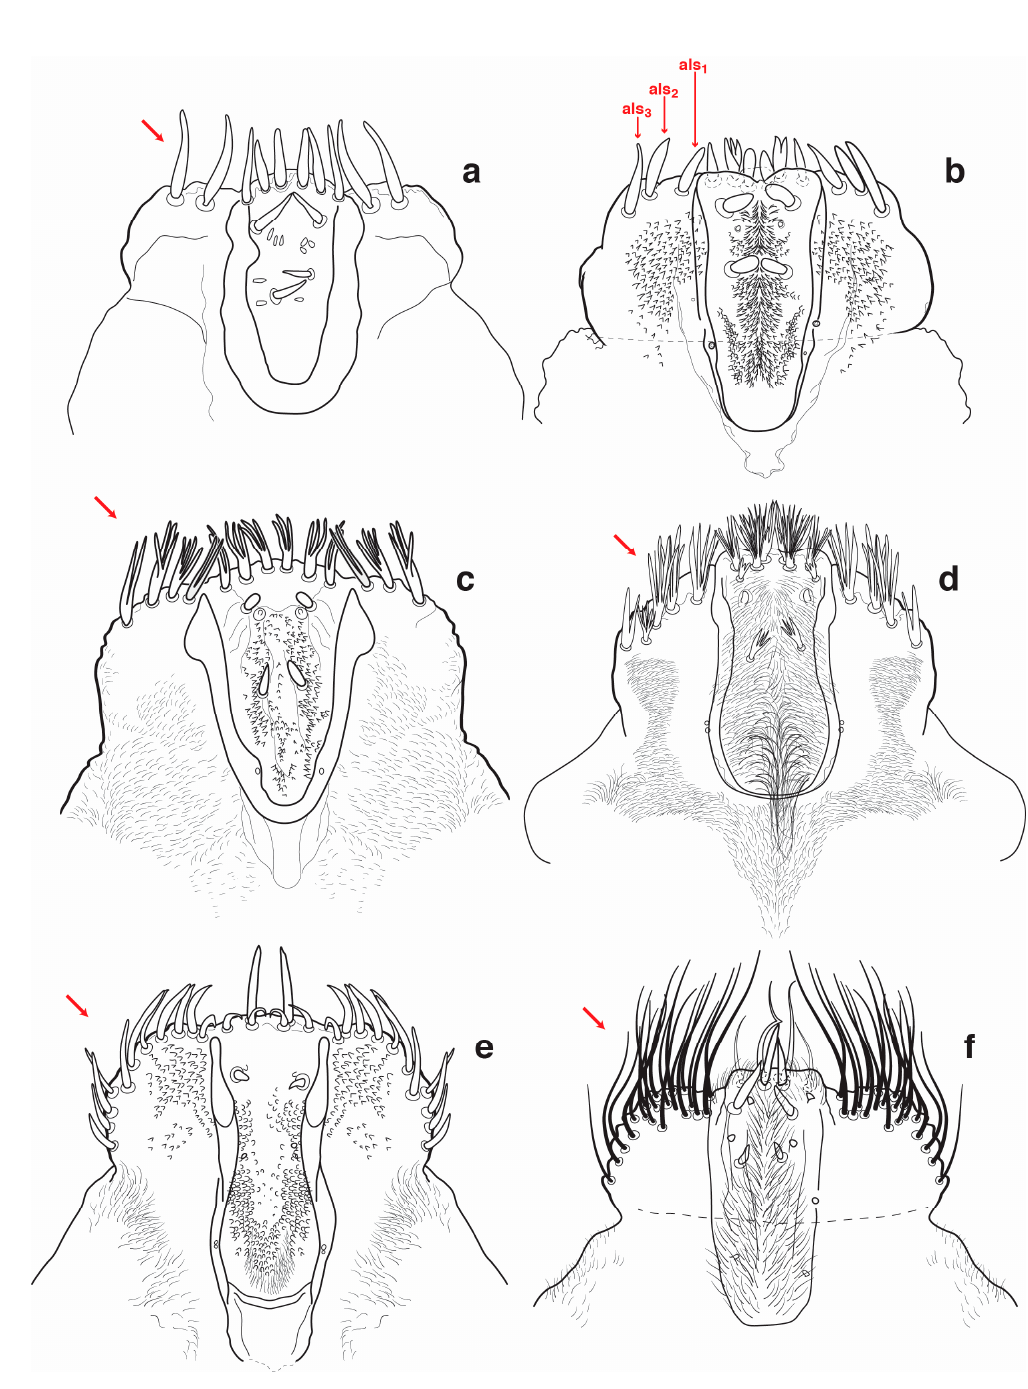
Figure 25. Epipharynx, larva: ( a ) Tryphetus ; ( b ) Poteriophorus ; ( c ) Sipalinus ; ( d ) Yuccaborus ; ( e ) Rhynchophorus ; and ( f ) Cyrtotrachelus . Als 1–3: anterolateral setae of epipharynx. 12. Shape of anterolateral epipharyngeal setae (als 1, 2, 3) (Figure 26) a. Tapering to apex